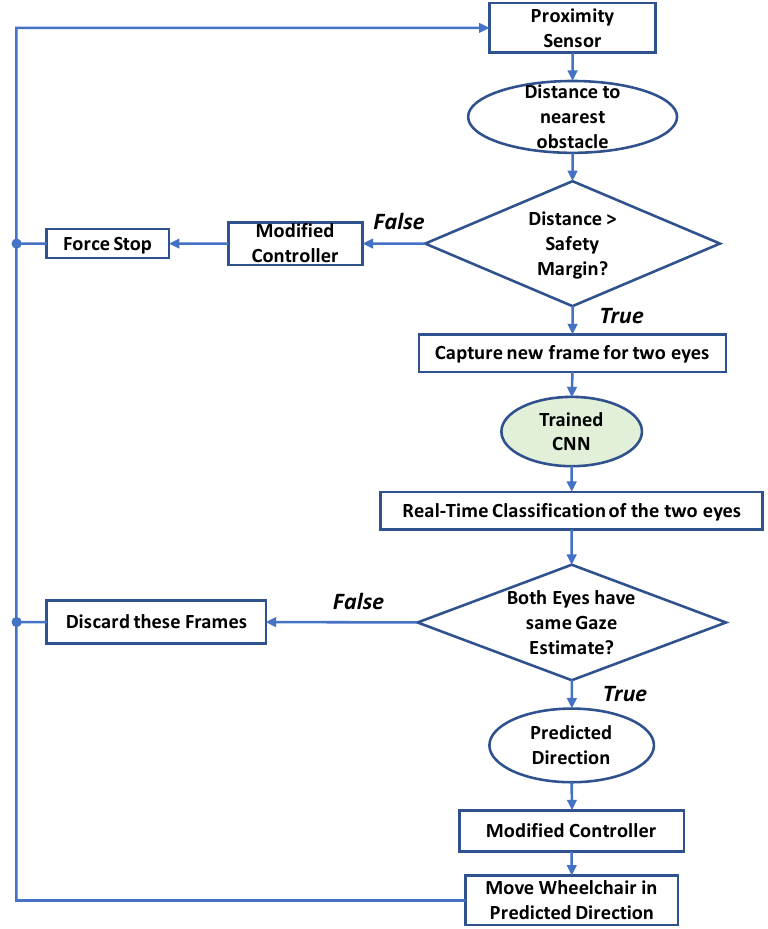
Figure 14. Flowchart for real-time classification and controlling the movement of the wheelchair.